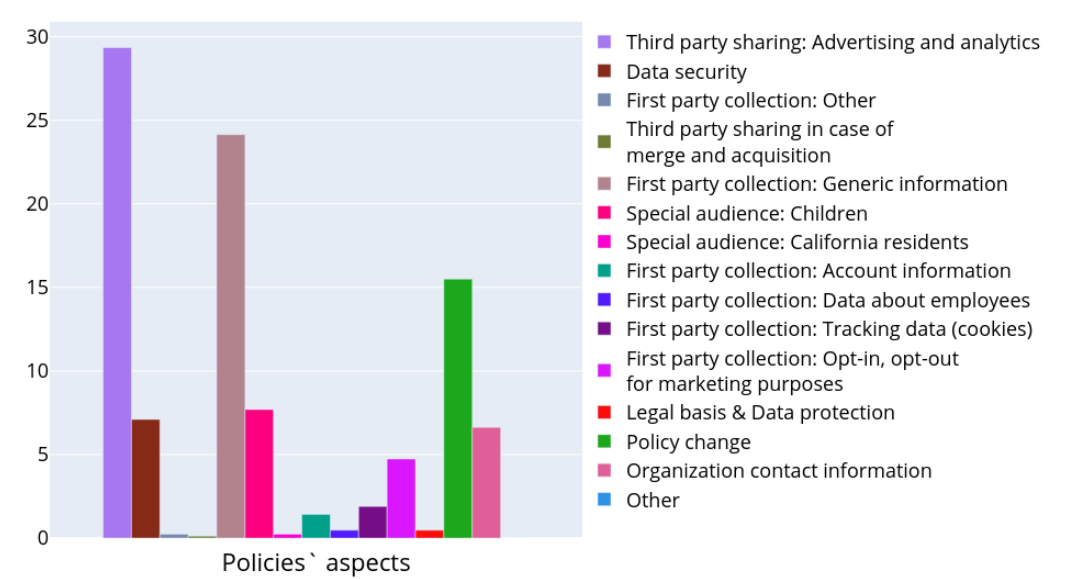
Figure 8. Distribution of various topics describing personal data usage scenarios in the collected corpus of privacy policies.